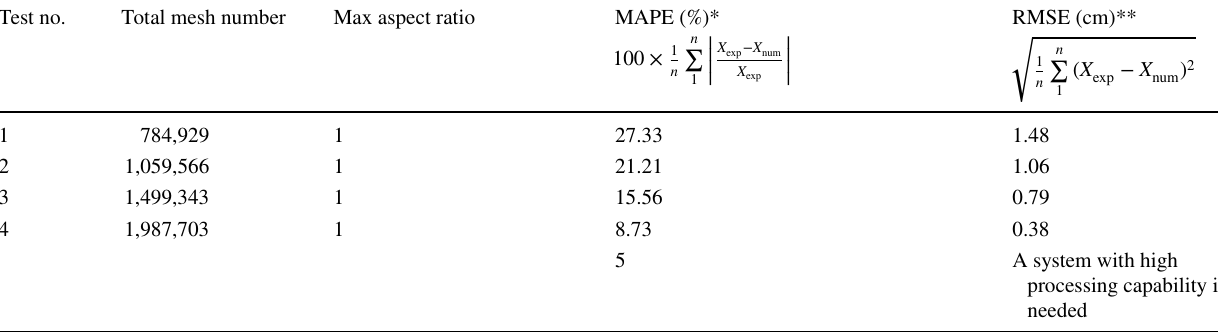
Table 2 Mesh sensitivity analysis for the present